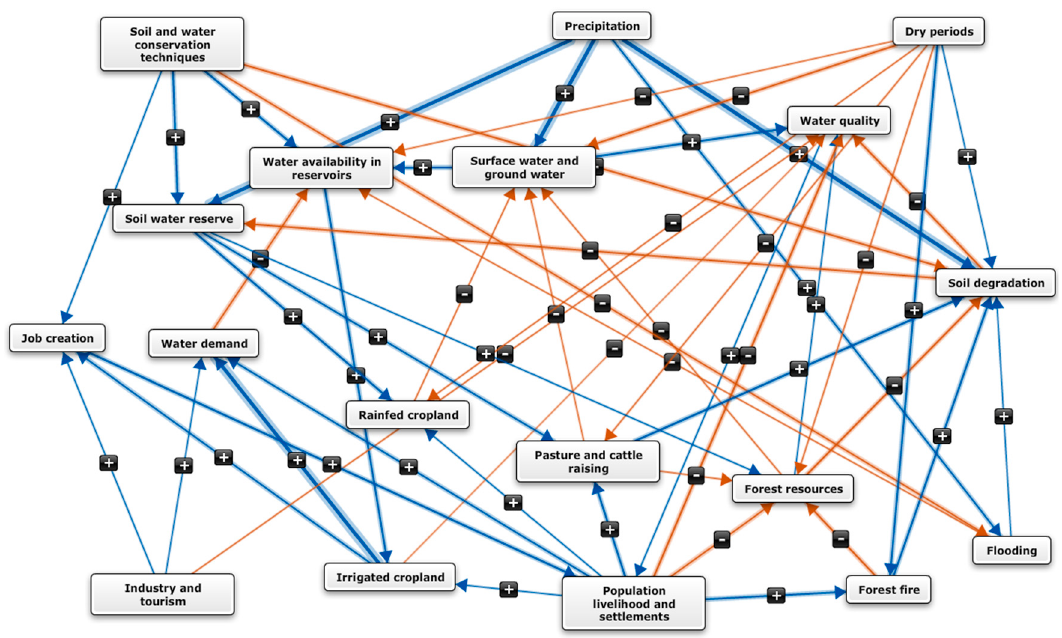
Figure 1. Fuzzy cognitive map developed for the Rmel river basin. Blue lines indicate positive relationships and red lines indicate negative relationships. Line thickness indicates to the strength of the relationships (e.g., a thick line corresponds to a strong relationship).